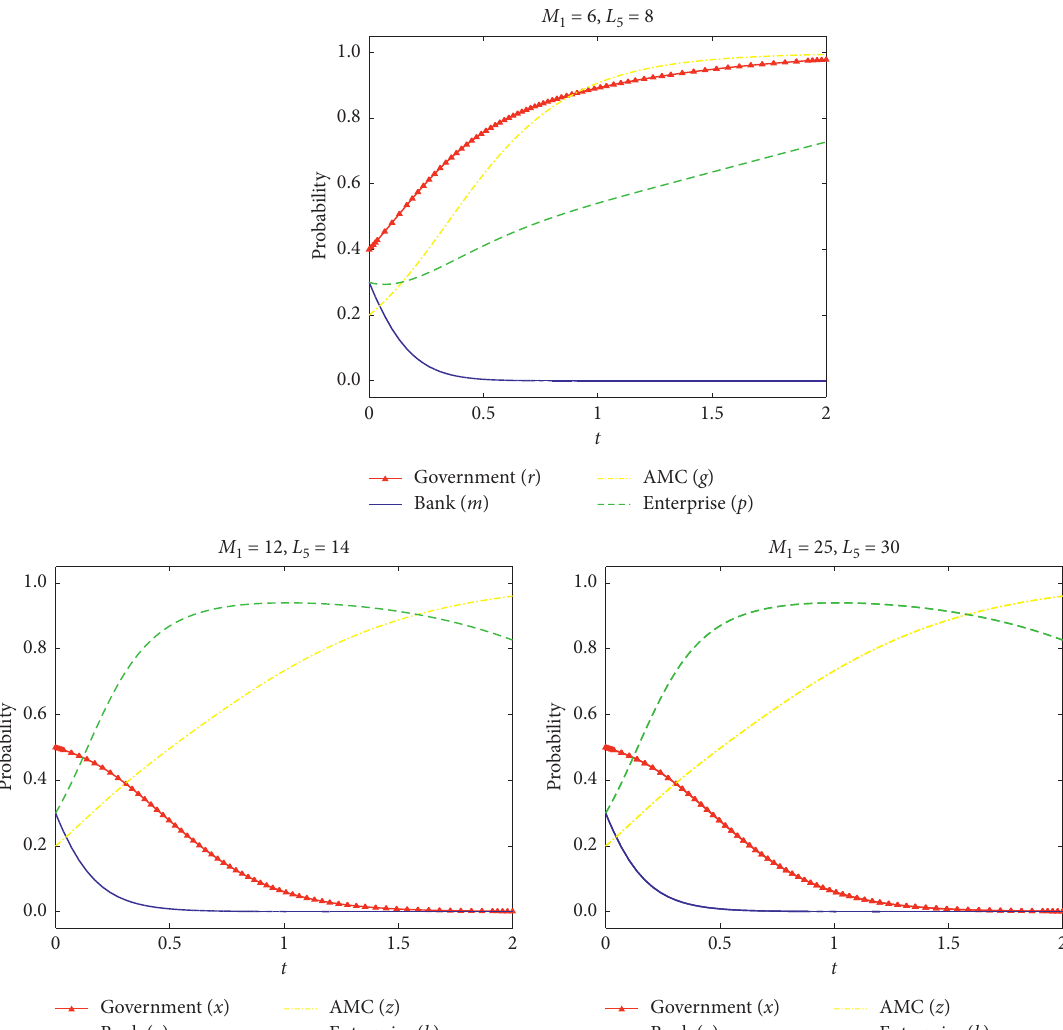
Figure 6: The influence of the strength of government rewards and constraint strength on the evolution of strategies of all